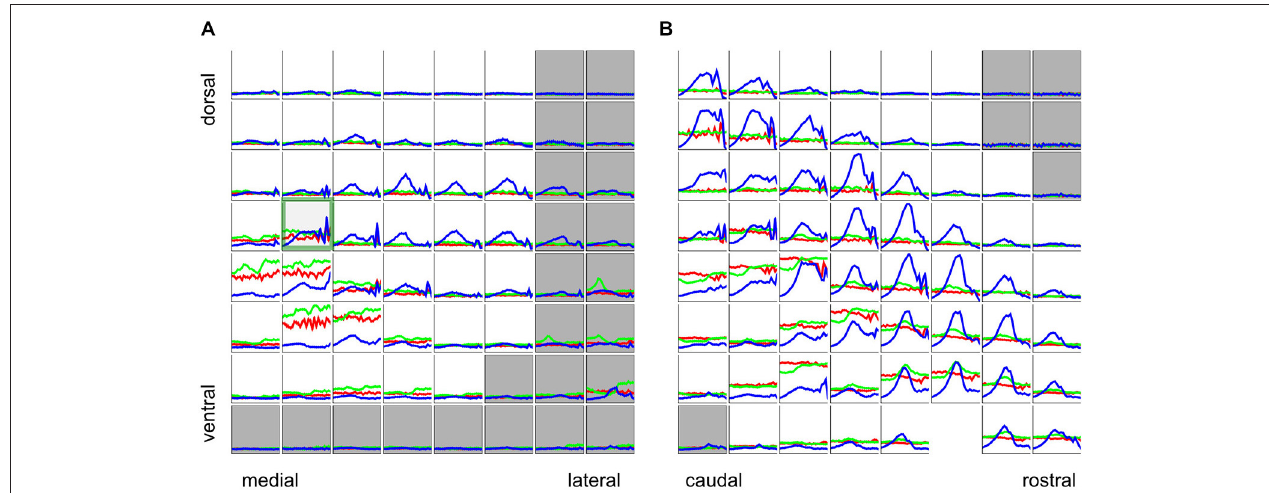
that in Figure 5B , i.e., the abscissas cover a range of [ − 5,3] octaves re 500 Hz, and the ordinates cover the range [ − 0.1 × y_max, y_max], where y_max is the maximum response observed across all stimulus types and recording sites in the corresponding multielectrode penetration. The curves are shown with error bars (mean + standard error) but error bars are very small and may be hard to see. Tuning curves from recording sites inside the ICc are plotted against a white background, those outside the ICc are shown against a light gray